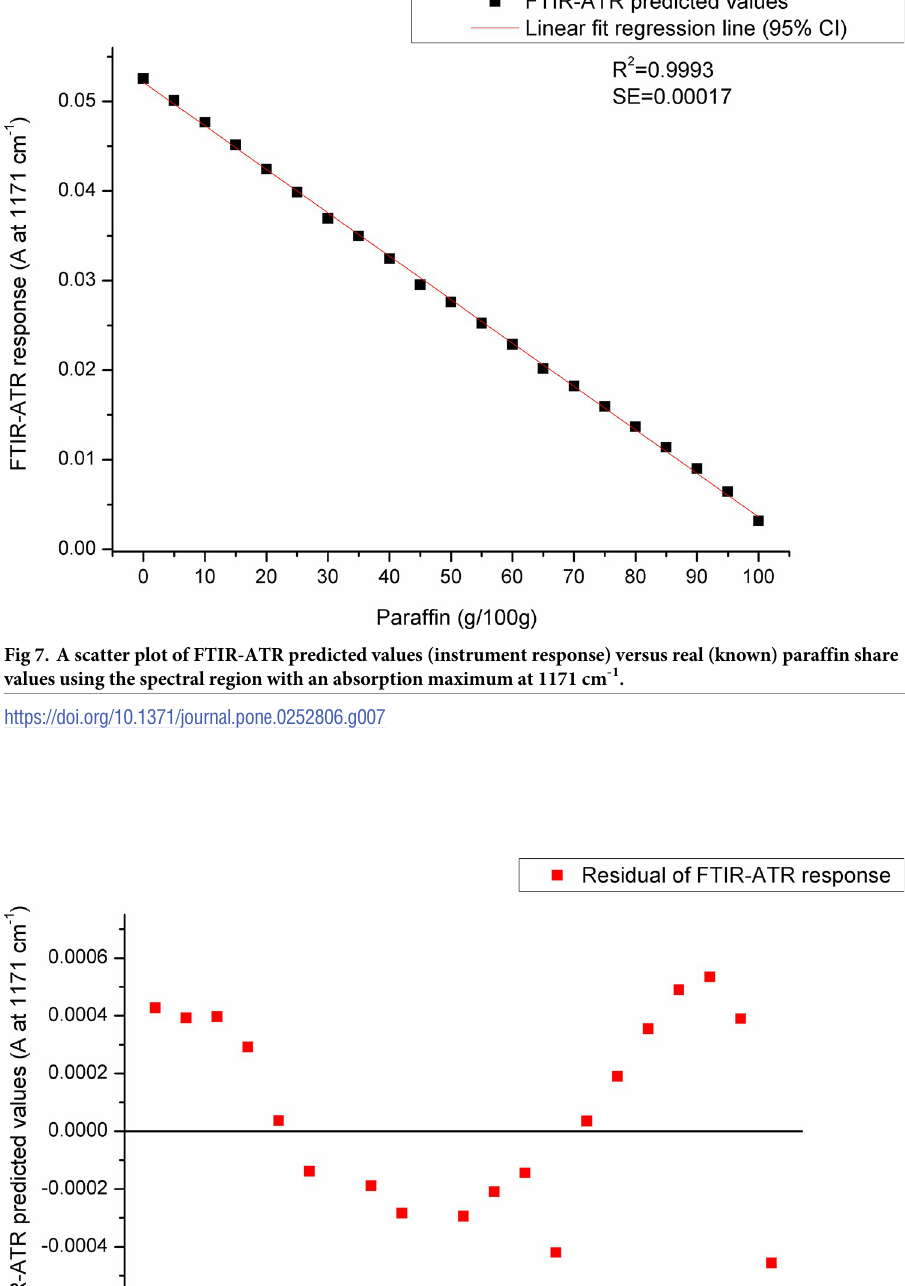
PLOS ONE | https://doi.org/10.1371/journal.pone.0252806 September 9,